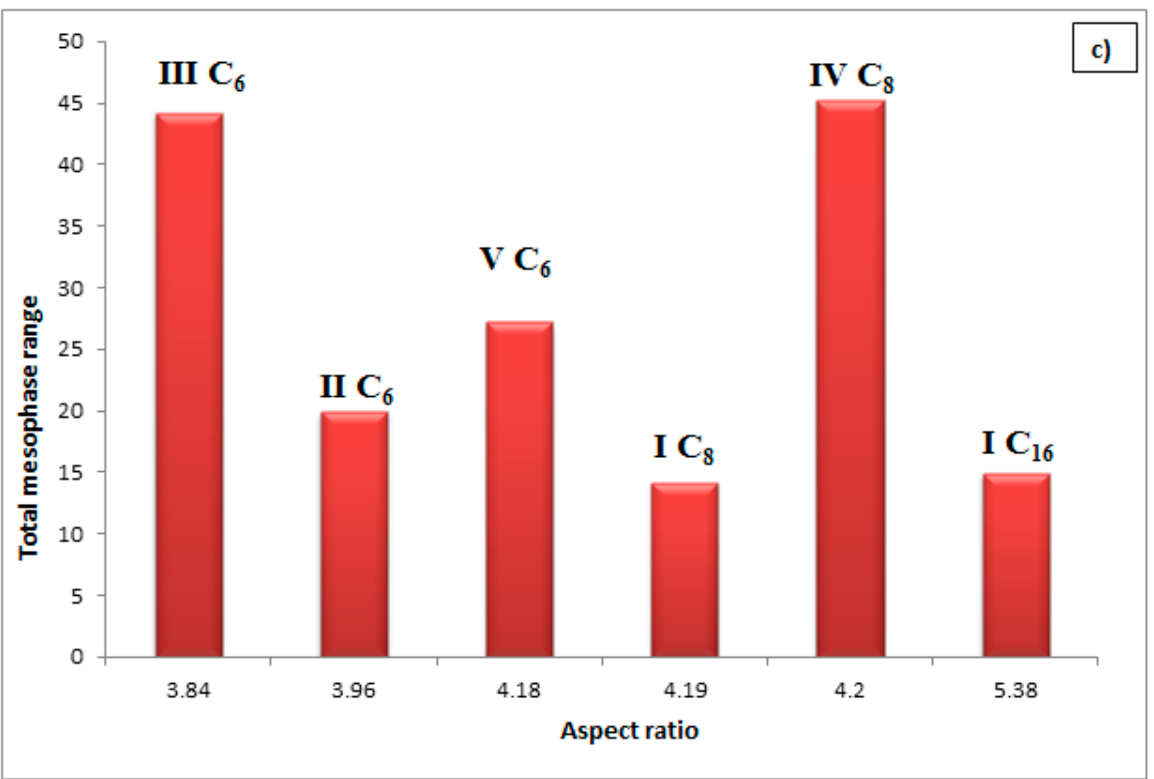
Figure 7. Dependence of aspect ratio with ( a ) Smectic range ( b ) Nematic range ( c ) Total mesophase range of compounds I C 8 , I C 16 , II C 6 , III C 6 , IV C 8 , and V C 6 .